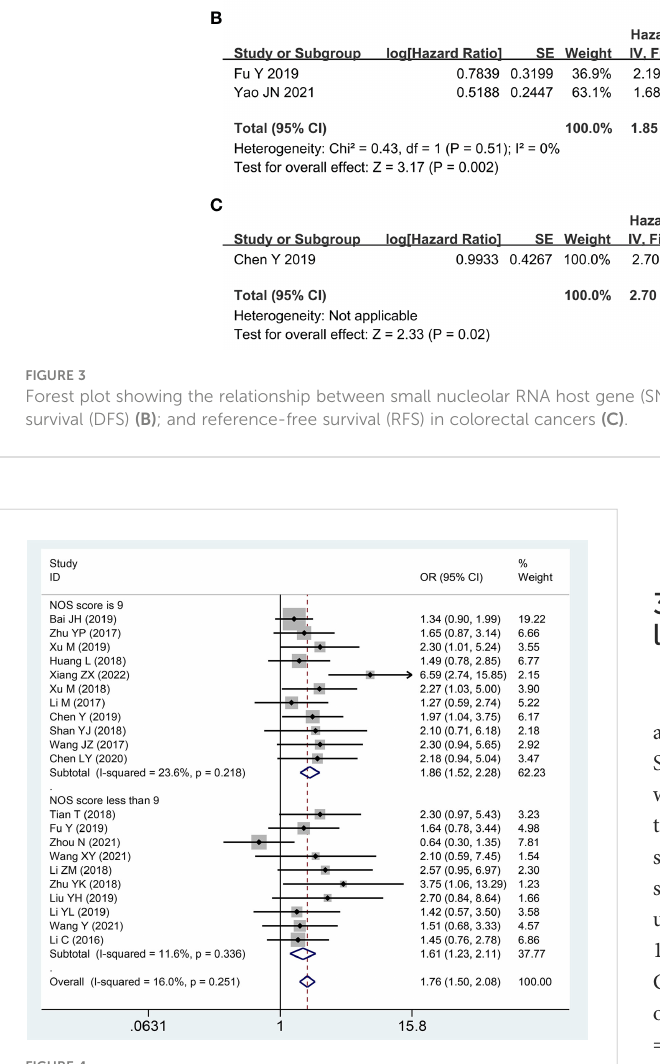
FIGURE 4 Forest plot showing the relationship between small nucleolar RNA host gene (SNHG) expression and TNM stage in colorectal